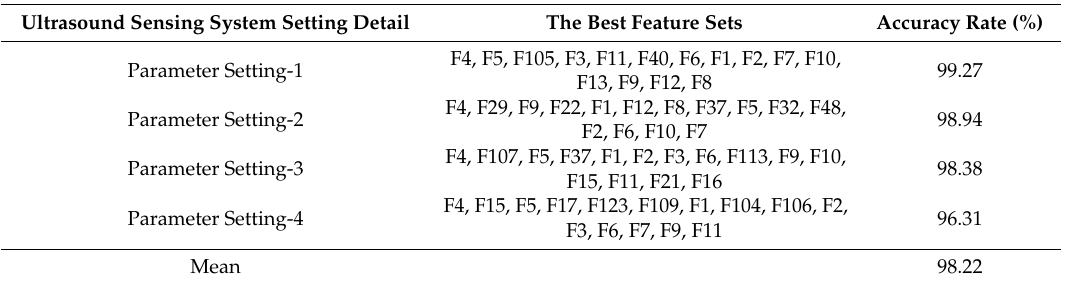
Table 17. Classification results of the SVM-enabled intelligent genetic algorithmic model when it chooses 15 features in each parameter setting.